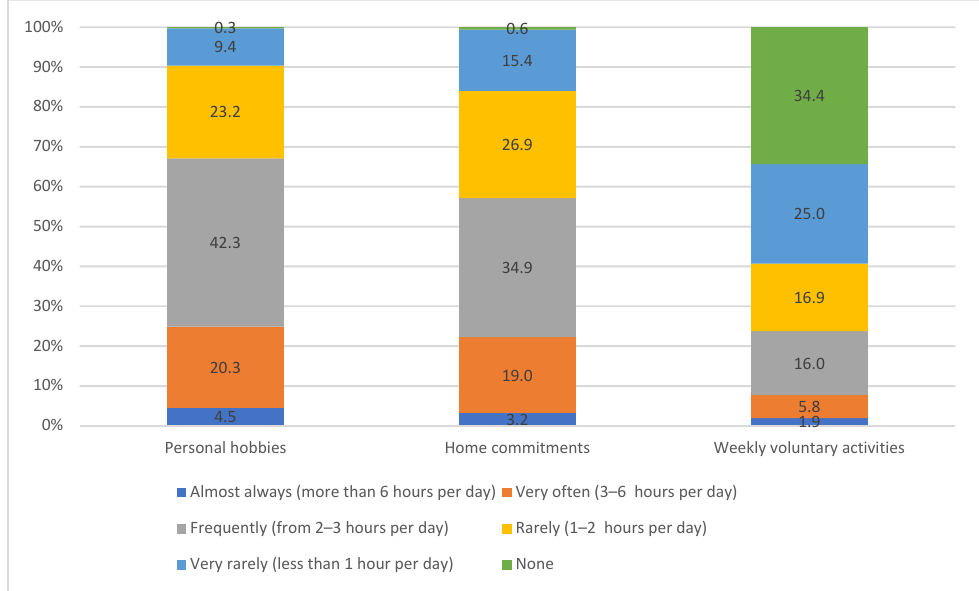
Figure 8. Student leisure activities.